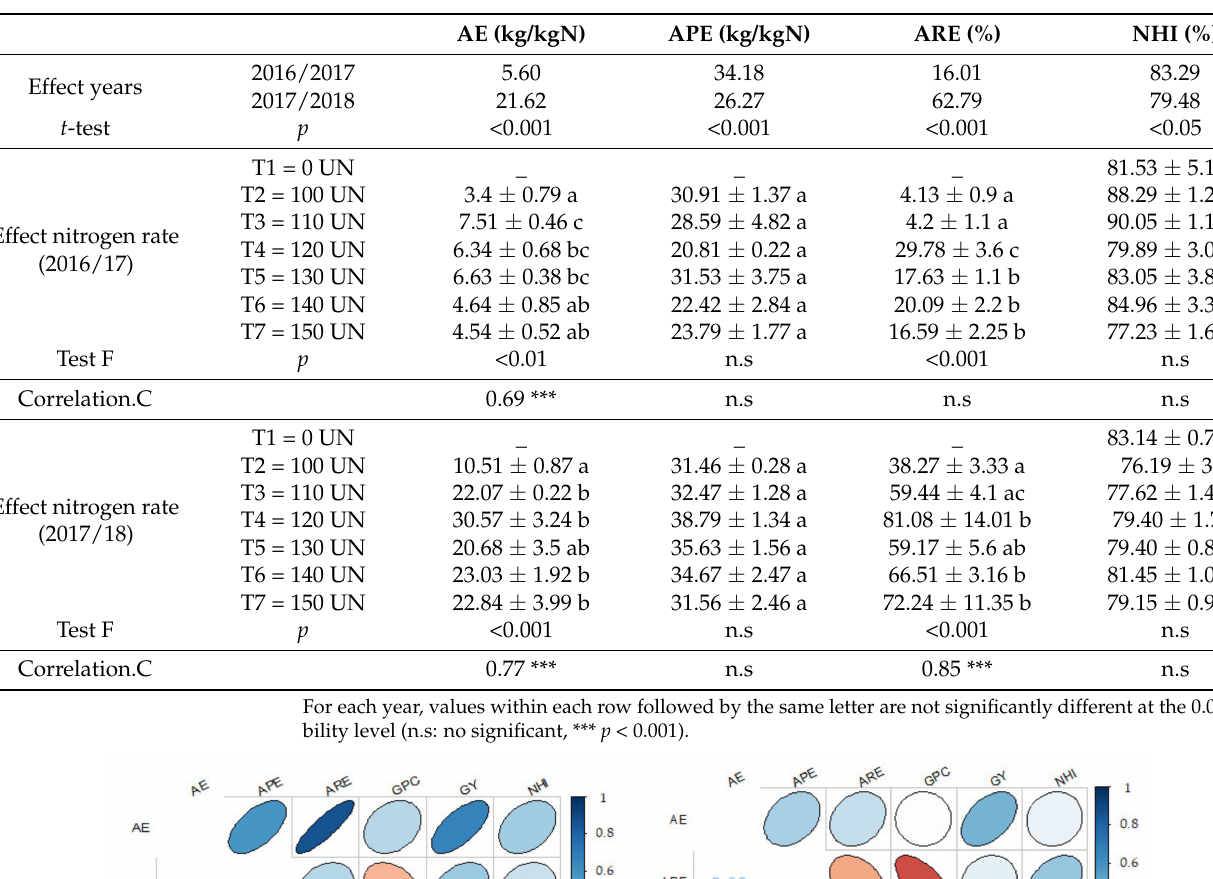
Table 4. Results of the ANOVA for the effect of fertilizer N rate on the nitrogen use efficiency components: agronomic efficiency (AE), agro-physiological efficiency (APE), apparent recovery efficiency (ARE), nitrogen harvest index (NHI), and the t -test for the effect of year.